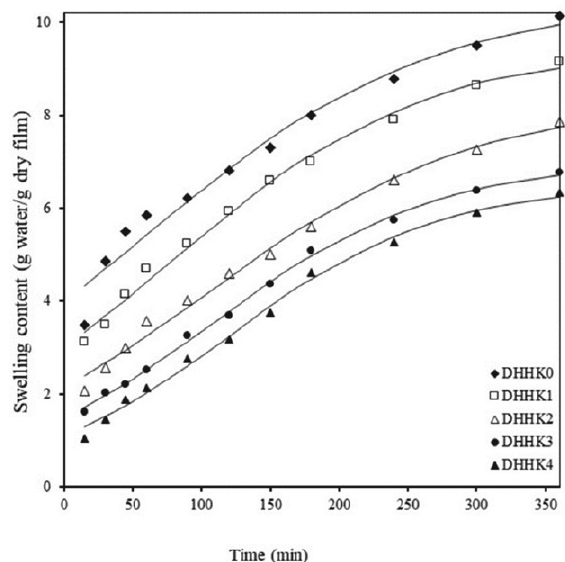
Figure 7. Fitting of the Lag phase sigmoid model of films of HPMC K100 M (H H ) matrix with varied kaolin swelling